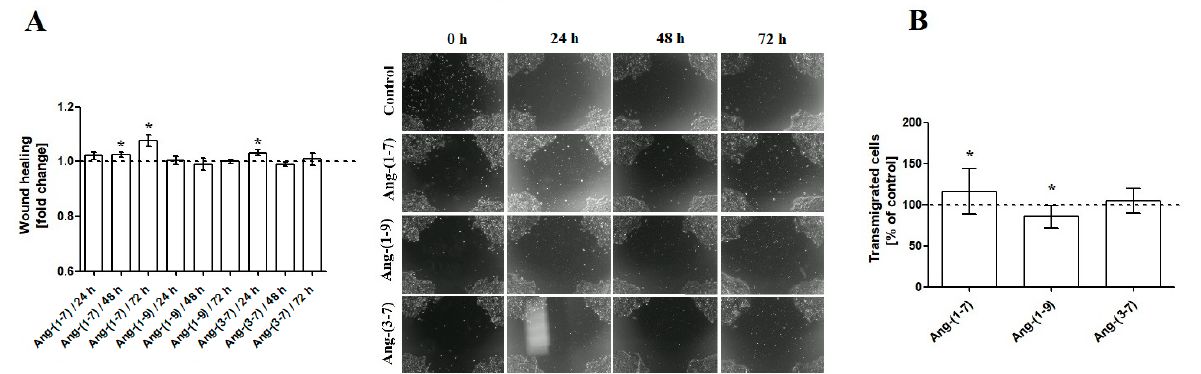
Figure 4. ( A ) The Wound Healing Assay and ( B ) Boyden Chamber Assay results, following the incubation (48 h) of OVPA8 cells with tested angiotensins in the medium without FBS (mean ± SD; one-way ANOVA with Tukey’s test: * p < 0.05).